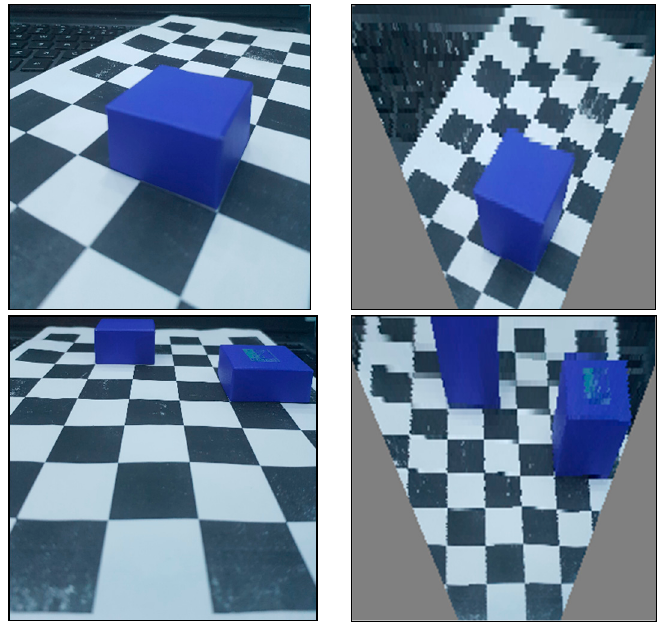
Figure 14. Relative obstacle position in frontal plane with four di ff erent obstacle positions.